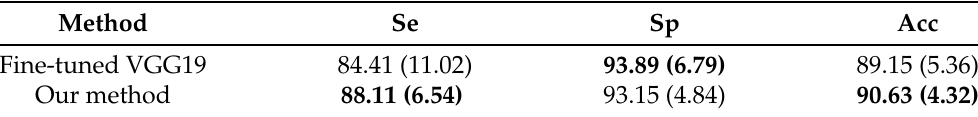
Table 2. Mean (standard-deviation) performance metrics obtained for the explored classifiers under the 100-random splits validation.